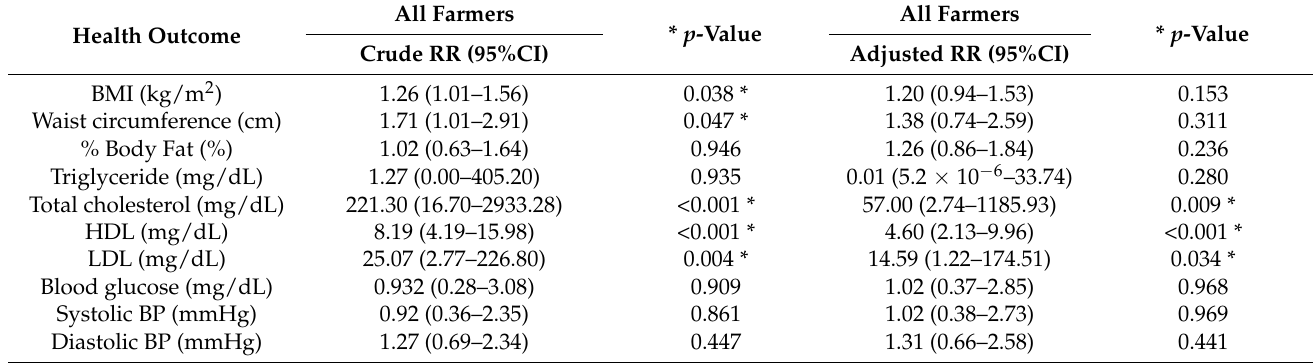
Table 6. Individual generalized linear model models for change in each metabolic biomarker per one unit of Ln Σ DEP. Adjusted models include covariates for age, gender, alcohol consumption, years of pesticide use, living within 1 km of a